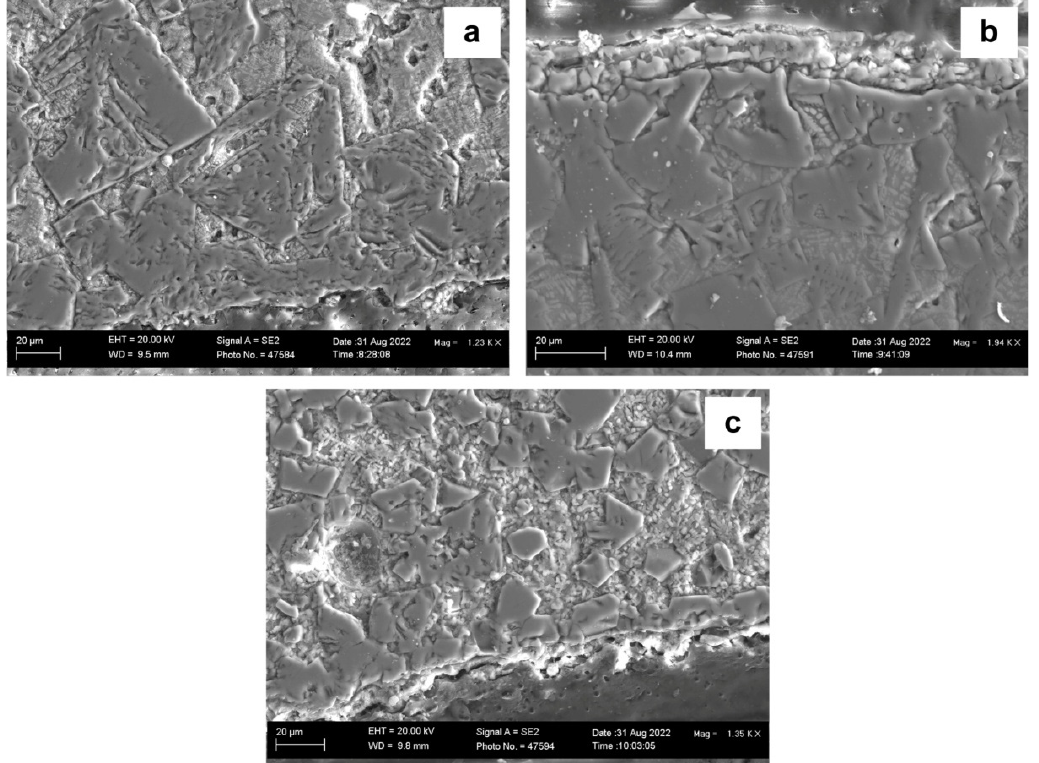
Figure 13. BSE images of post-weld slags: ( a ) = MP2 slag at 1230× magnification; ( b ) = MP4 slag at 1940× magnification; ( c ) = MP5 slag at 1350× magnification.